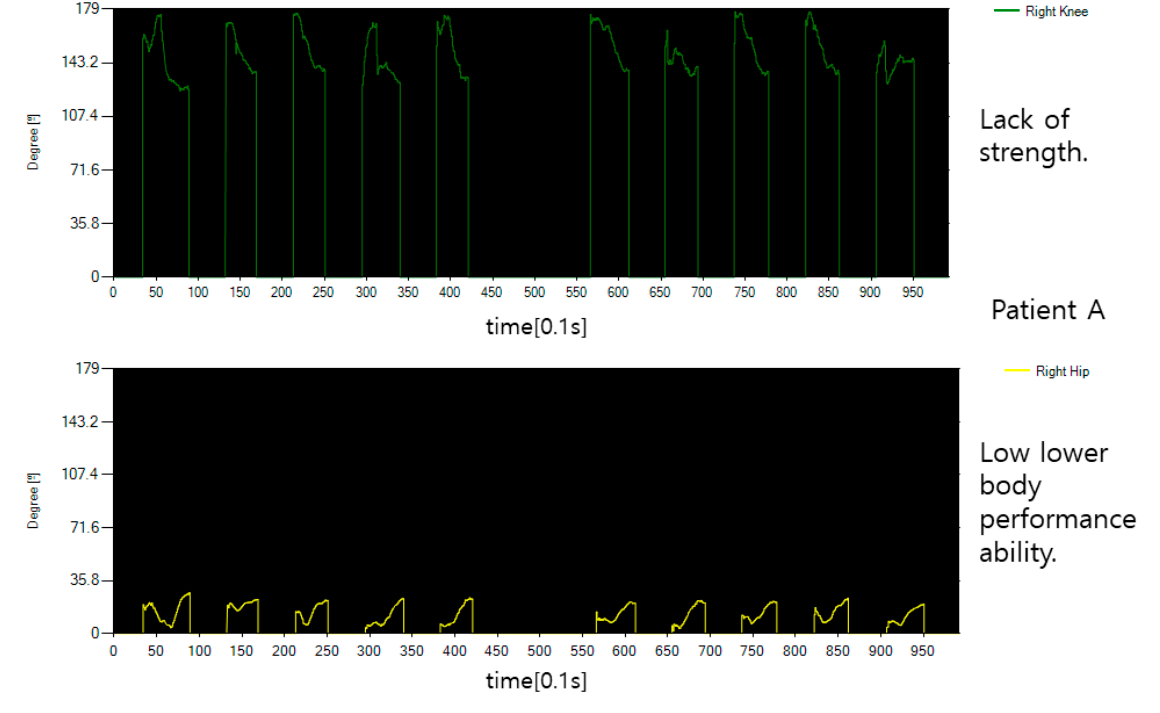
Figure 13. The angle data of patient A sitting motion.